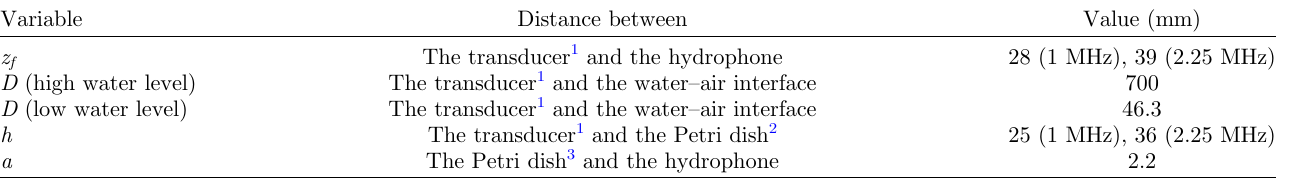
Table 1. Table of distances and heights.